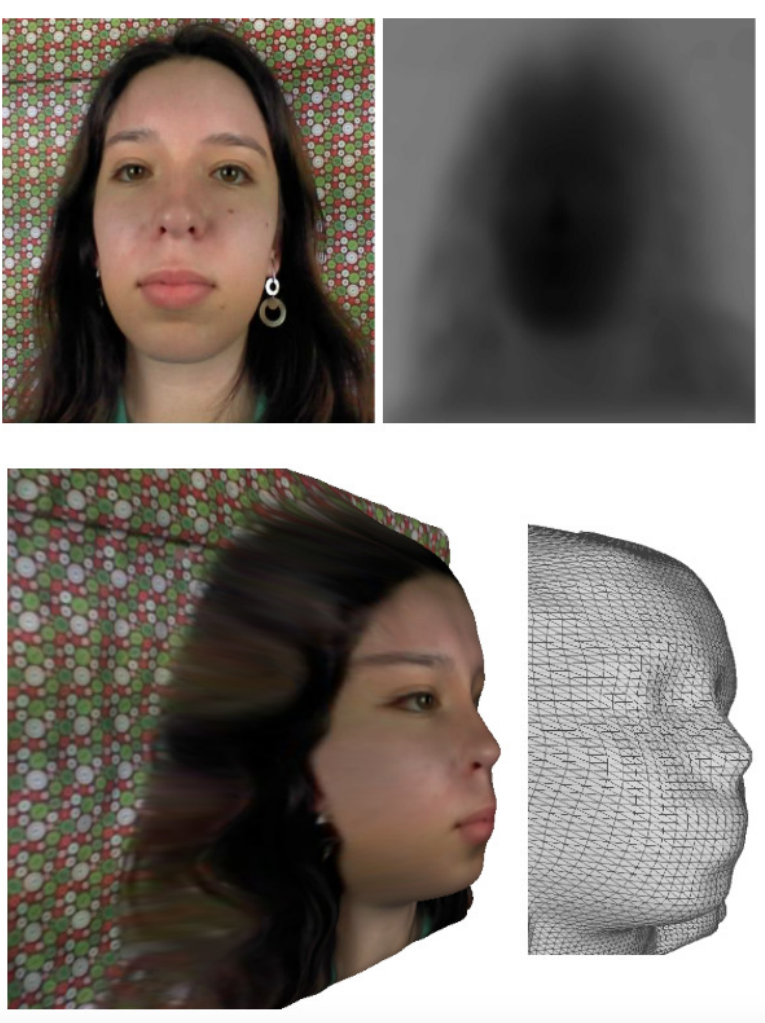
Figure 5. Representation of the modeling process for an RGB-D image. The process starts with the RGB image, passing by the depth map, 3D reconstruction and mesh.